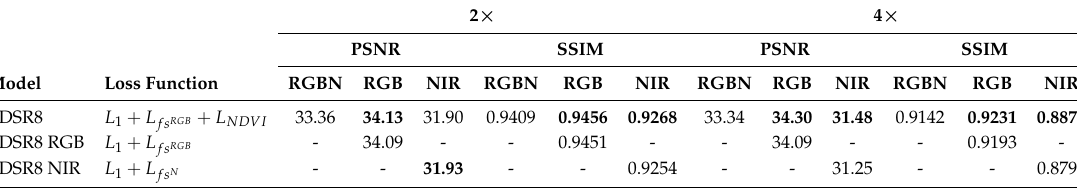
Table 8. PSNR and SSIM metrics obtained with different bands as input/output using TTA in the test set. 2 × 4 × PSNR SSIM PSNR SSIM Model Loss